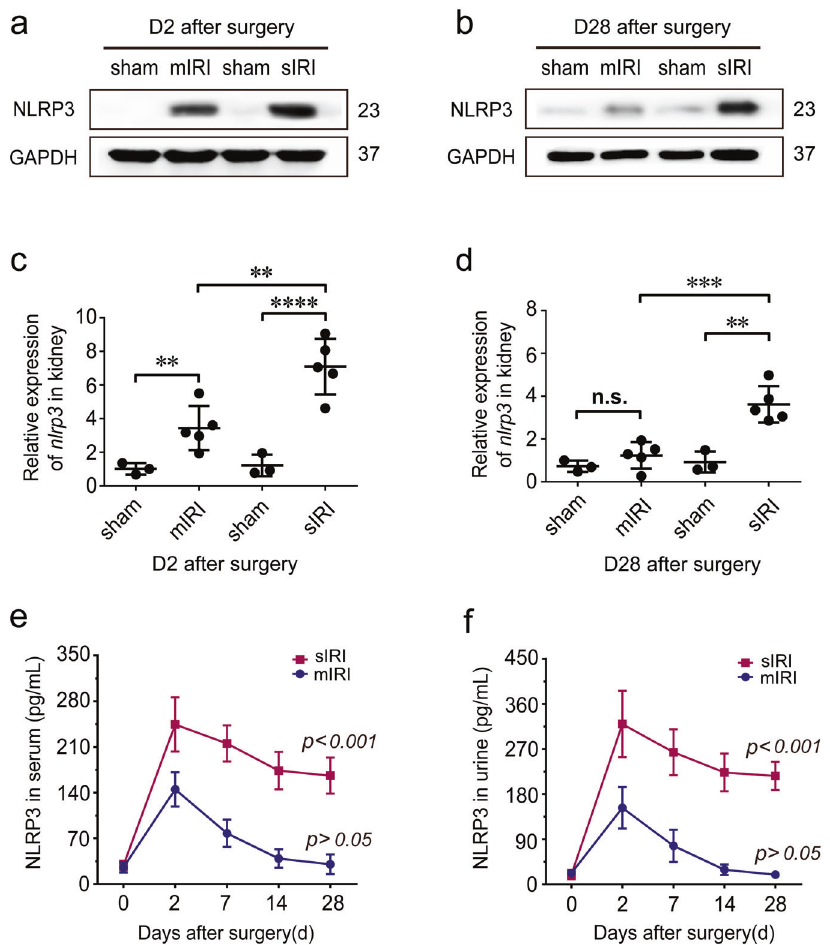
Fig. 2 Dynamic expression of renal NLRP3 following AKI. a , b Representative western blot analysis of NLRP3 (23 kDa) protein in injured kidneys at indicated time points; GAPDH was used as a loading control. c , d Relative expression of NLRP3 mRNA in kidneys in injured kidneys at indicated time points. e Serum levels of NLRP3 from mild and severe group mice. *** P < 0.001 means signi fi cant versus baseline. f Urine levels of NLRP3 from mild and severe group mice. *** P < 0.001 means signi fi cant versus baseline. n = 3 mice for the sham group, n = 5 for mild and severe AKI per time-point group, respectively. Data are mean ± SD. ** P < 0.01, *** P < 0.001, **** P < 0.0001. ns not signi fi